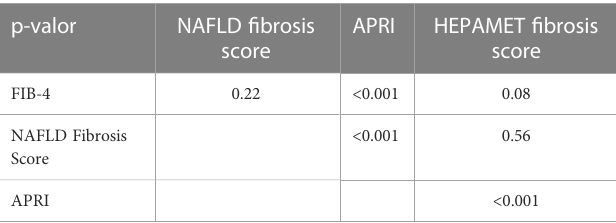
TABLE 6 Contrast between different non-invasive fi brosis